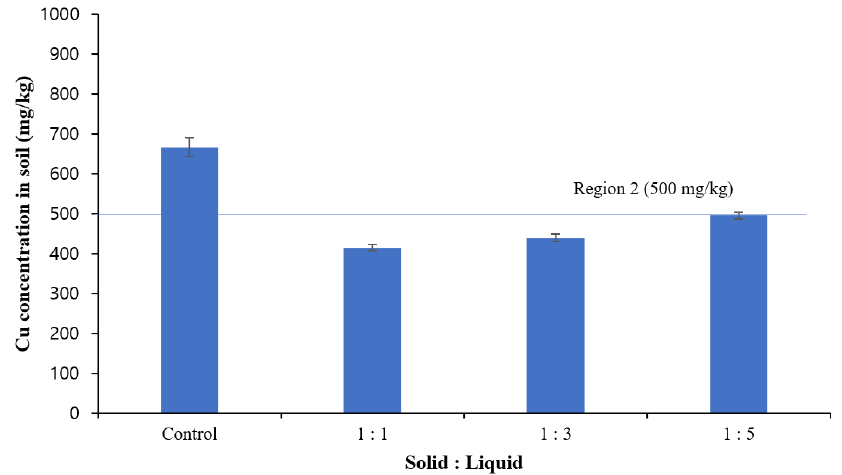
Figure 6. Cu concentrations remaining in the soil using a solid-liquid ratio of 1:1, 1:3 and 1:5 for the washing of soil.